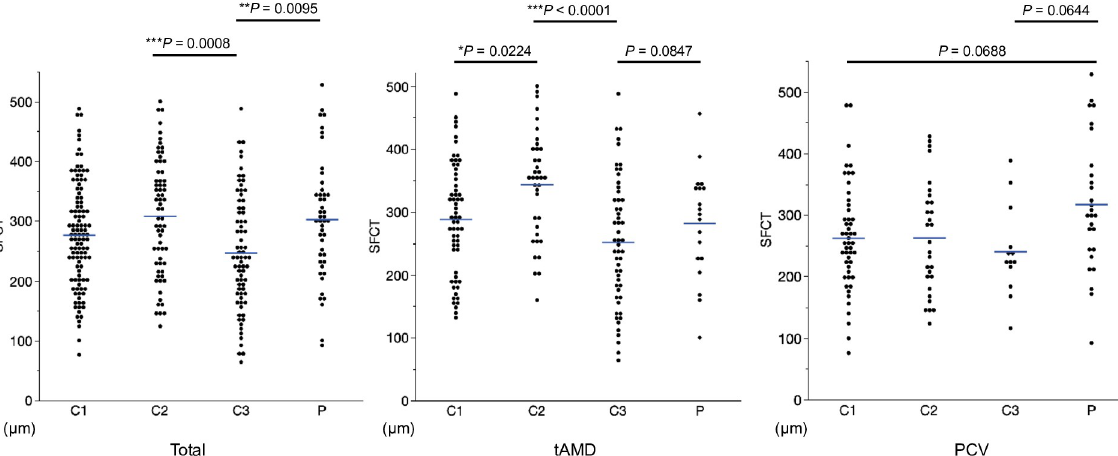
Fig 2. Scatter plots for the fellow eye’s SFCT in each category. Both Category 2 and Category P show significantly higher SFCT than Category 3 ( P = 0.0008 and P = 0.0095, respectively). Similarly, SFCT in Category 2 was significantly thicker than Category 3 ( P < 0.0001) in the fellow eye of tAMD. SFCT in Category P showed a trend to be higher than Category 1 or Category 3 in the fellow eye of PCV ( P = 0.0644 and 0.0688, respectively). Tukey-Kramer HSD test. Horizontal blue bars indicate the mean SFCT in each group. � P < 0.05, �� P < 0.001, ��� P < 0.0001.